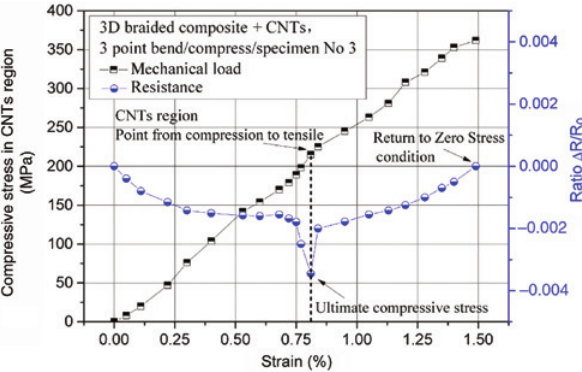
Figure 11: Characteristics of specimen C of CNTs for three-point bending in the compressive region.